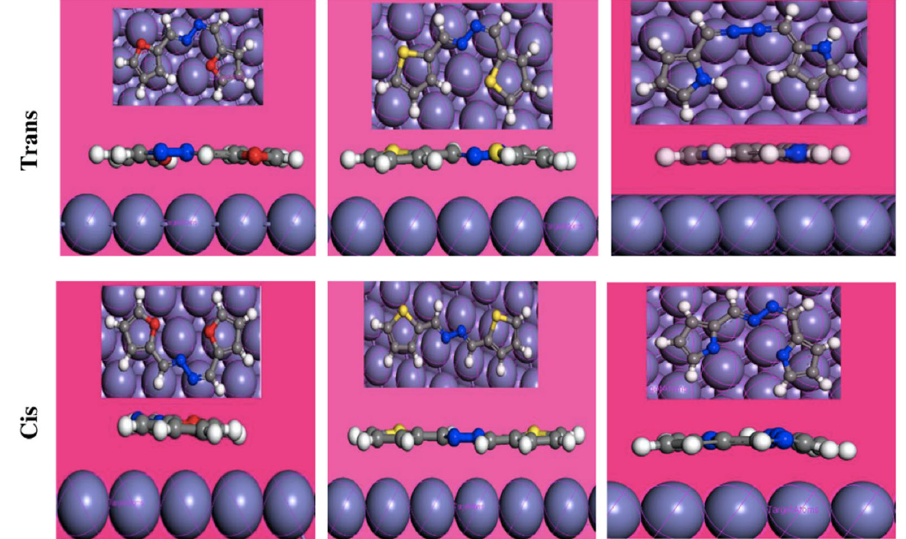
Figure 4. Side and top views of most stable adsorption configurations for (Fe (111)/(E&Z)-HZi/Gas phase) systems at 308 K (Belghiti et al., 2019) [66].